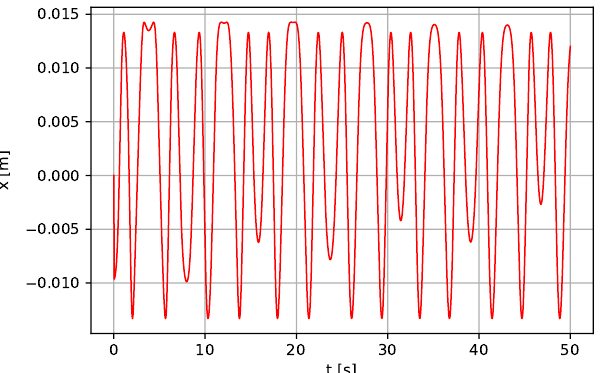
Figure 22. Linear displacement x pc ( t ) of the piston (Case II—a variable length concept of the pendulum pump) for c p = 1 N s m − 1 , ω = 0.4 rad s − 1 . · · ·